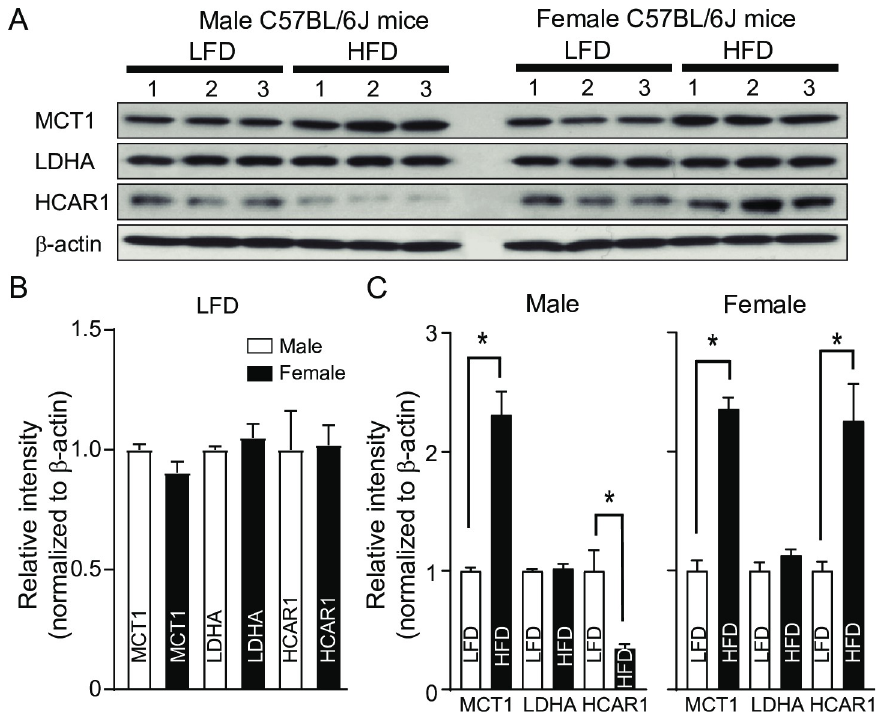
Fig 2. High-fat feeding differentially regulates HCAR1 protein expression in male and female mice. A . Images of Western blot of MCT1, LDHA, and HCAR1 in BAT from mice fed LFD or HFD for 5 weeks at 28˚C (n = 3 mice/ group/sex). B. Summary plot showing expression of MCT1, LDHA, and HCAR1 in male and female mice fed LFD for 5 weeks at 28˚C. There were no differences in the expression of MCT1, LDHA, and HCAR1 (open bar: males, filled bar: females). C. Summary plot showing expression of MCT1, LDHA, and HCAR1 in male and female mice fed LFD or HFD for 5 weeks at 28˚C (open bar: mice fed LFD, filled bar: mice fed HFD). High-fat feeding differentially regulated HCAR1 expression in male and female mice. � p <